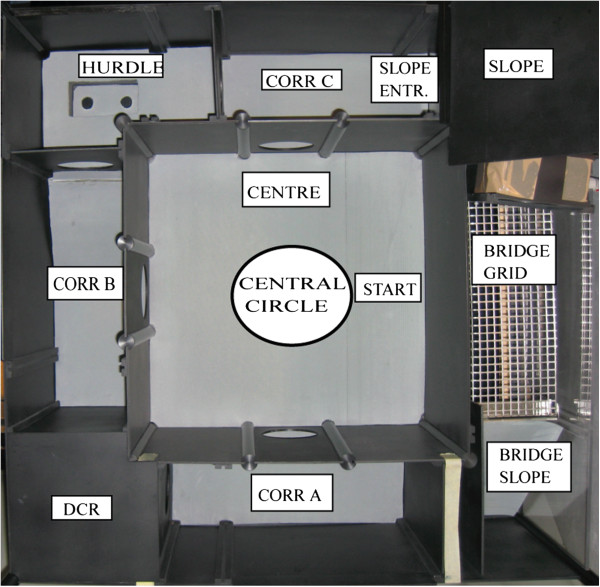
The Multivariate Concentric Square Field (MCSF) arena and the defined zones. CORR A, B and C, indicate corridors A-C; DCR is the dark corner room; and SLOPE ENTR is the slope entrance. START indicates where the animal is placed when introduced to the arena. Picture modified from [28].